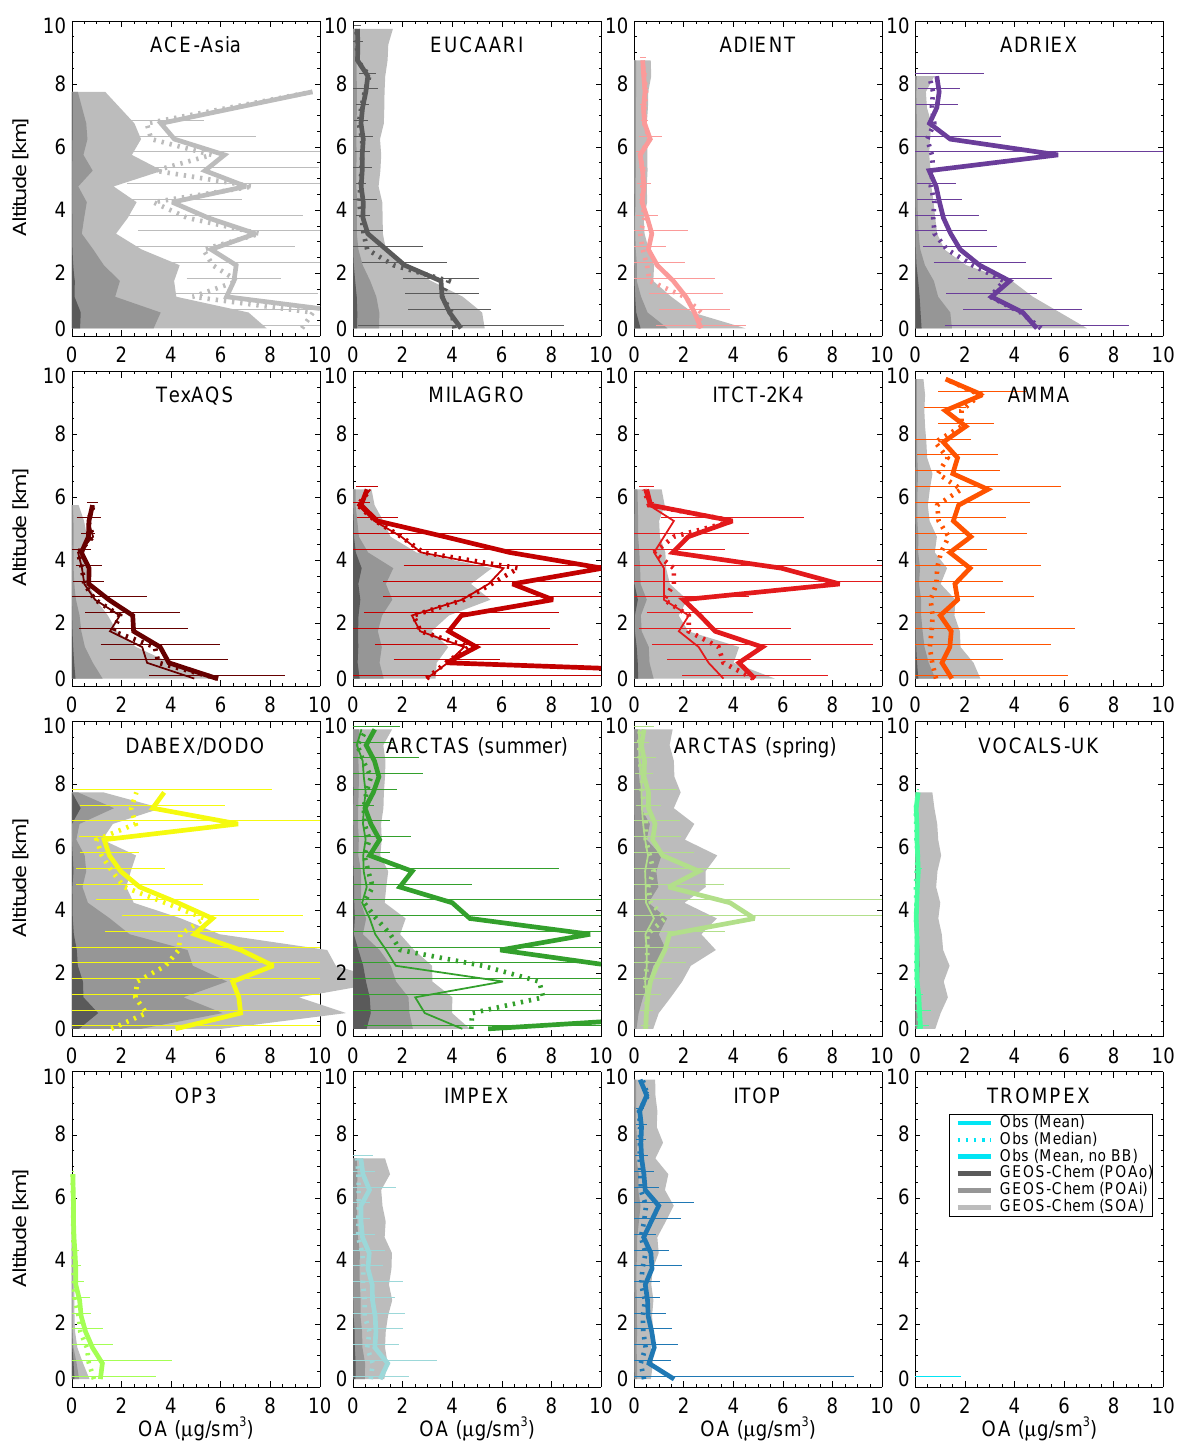
Fig. 11. As in Fig. 4, mean simulated OA (grey) is compared to observed (color) concentrations for 17 field campaigns, however the model simulation here includes an additional source of anthropogenic SOA (ASOA) of 100Tgyr − 1 estimated by scaling simulated ASOA by a factor of